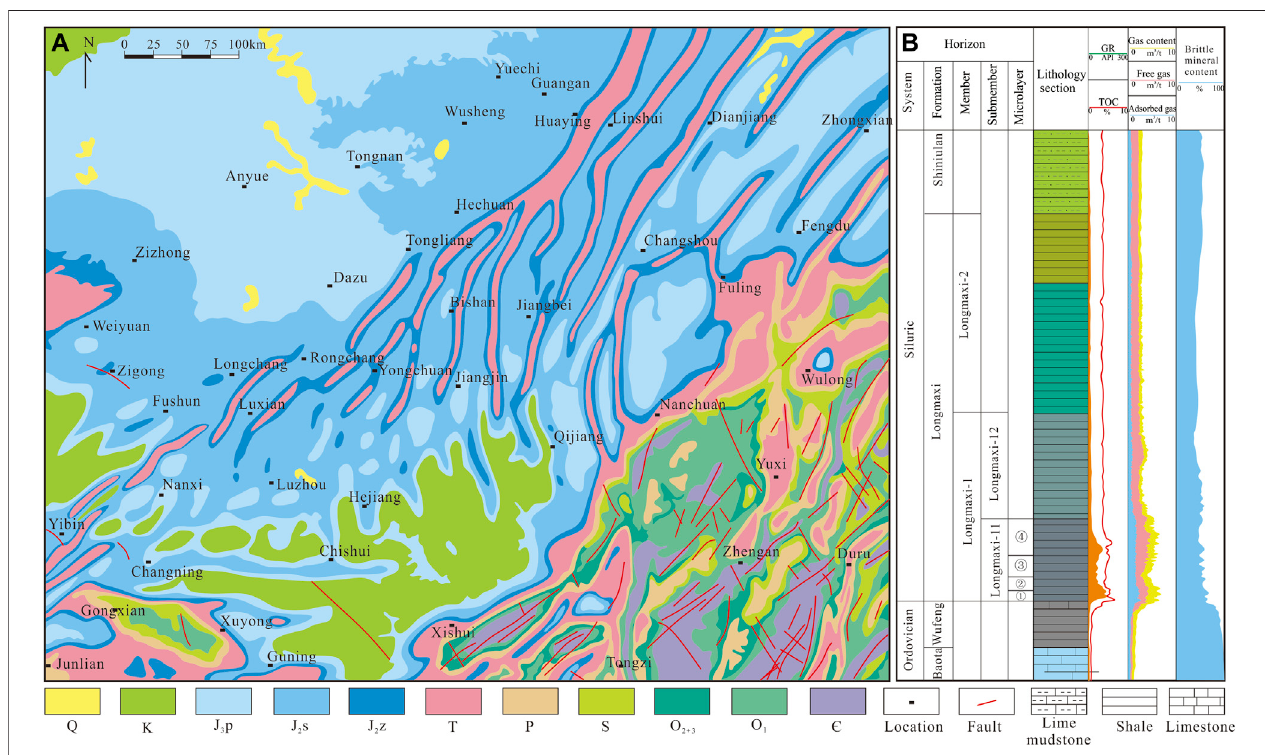
FIGURE 1 | Geological setting of the Luzhou block. (A) . Structural location; (B) . Comprehensive stratigraphic diagram.